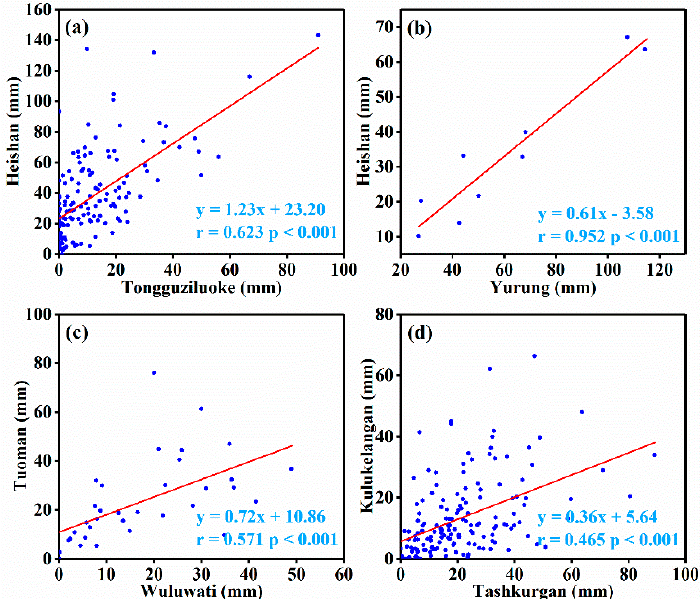
Figure 3. Correlation of monthly precipitation in summer between different hydrological and meteorological stations in mountainous areas. ( a ) Tongguziluoke and Heishan, ( b ) Yurung and Heishan, ( c ) Wuluwati and Tuoman, ( d ) Tashkurgan and Kulukelangan.